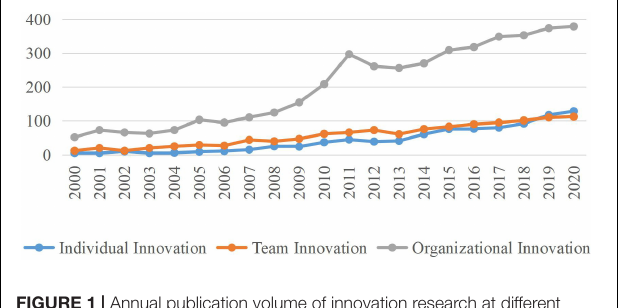
FIGURE 1 | Annual publication volume of innovation research at different levels (2000–2020).